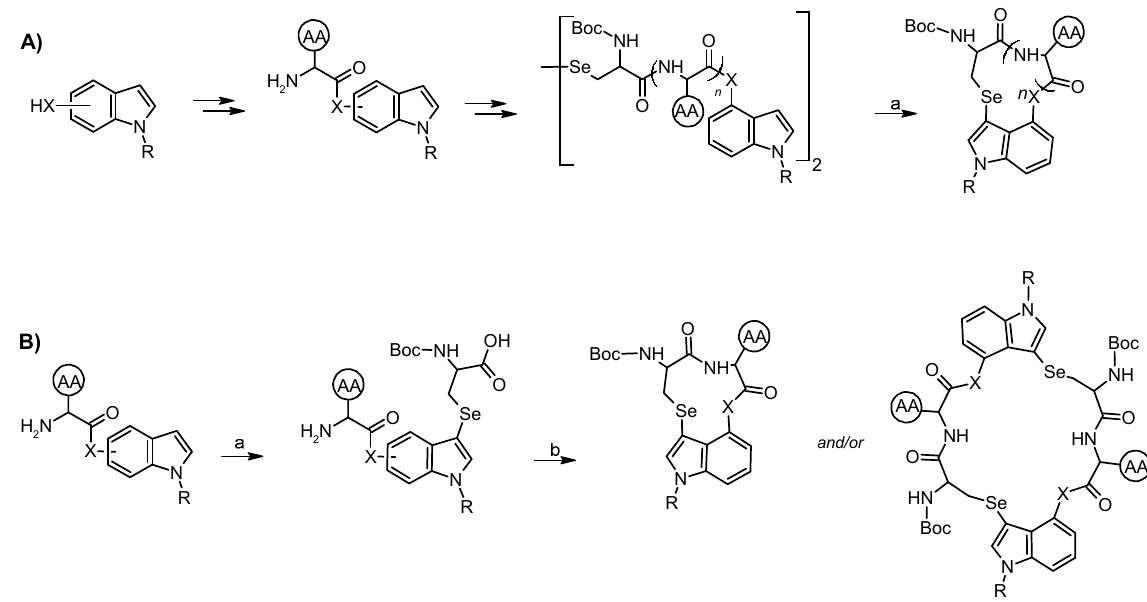
Scheme 8. Synthesis of macrocycle via formation of Se − C bond between Sec and indole ring (ap- proach ( A )) and synthesis of macrocycle containing the selenylated indole via amide bond (ap- proach ( B )), conditions: (a) RB (Rose Bengal) (0.1 equiv.), LED 460 , MeCN; (b) HOBt (1 equiv.), EDC (1.5 equiv.), DMF.